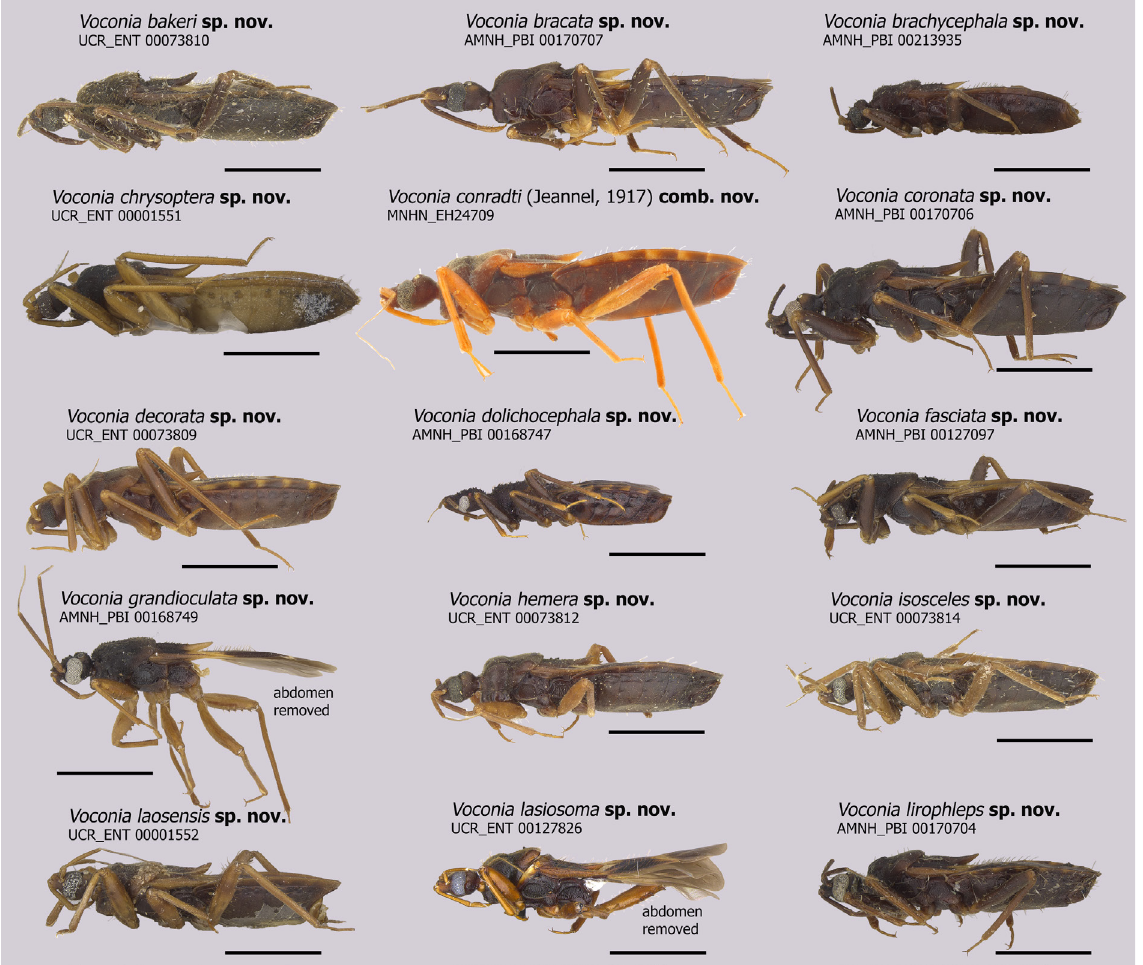
Fig. 9. Lateral habitus of species of Voconia Stål, 1866. Scale bars = 3